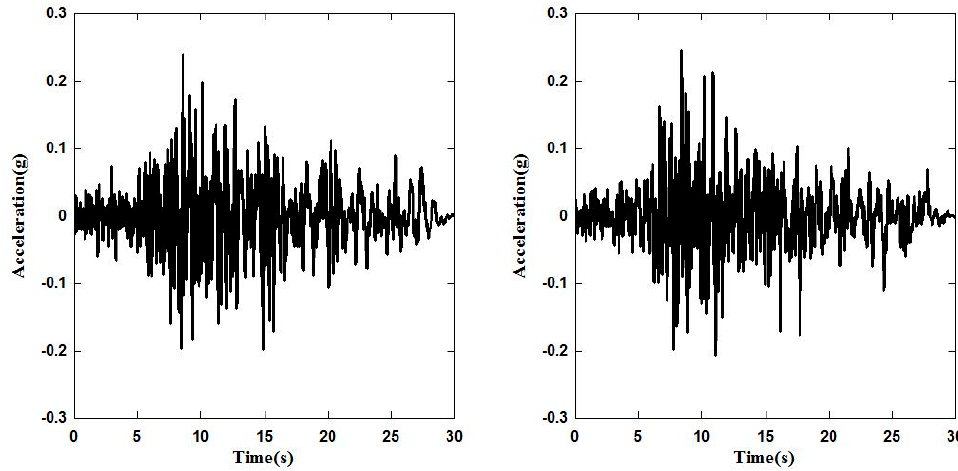
Figure 4. Time history of Guangdong NPP site.